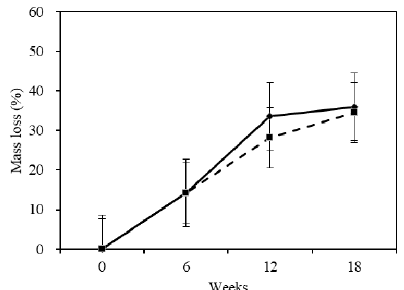
Figure 1. Mass loss of samples after degradation. The continuous and discontinuous lines in the figure caption indicates sapwood and heartwood. The error bar is according to a confidence interval of 95%.